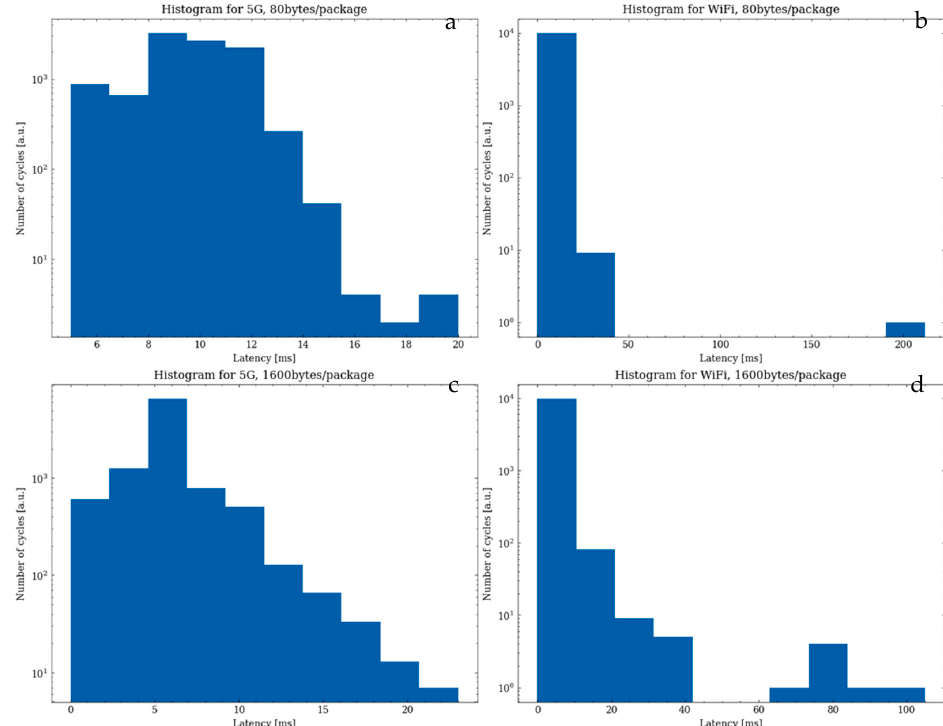
Figure 10. Semi-logarithmic histogram plots of 5G communication and conventional 2.4 GHz WiFi- communication. Mean values and standard deviation for WiFi: ( a ): 1.48 ± 2.89 ms (80 bytes), ( b ): 4.83 ± 8.44 ms (1600 bytes). Mean values and standard deviation for 5G communication: ( c ): 9.25 ± 1.85 ms (80 bytes), ( d ): 5.69 ± 2.17 ms (1600 bytes). All histograms were created by a communication by the described protocol with 10,000 data packages for each test. Source: own-elaboration .